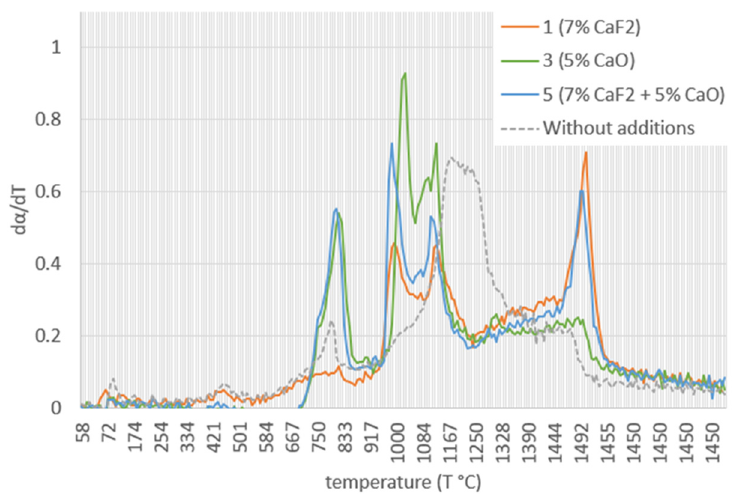
Figure 2. Derivative conversion curves for experiments 1, 3, and 5 using the R2/l concentrate. The dotted line indicates a conversion curve obtained without any slag modification and with a higher amount of gangue minerals [9].